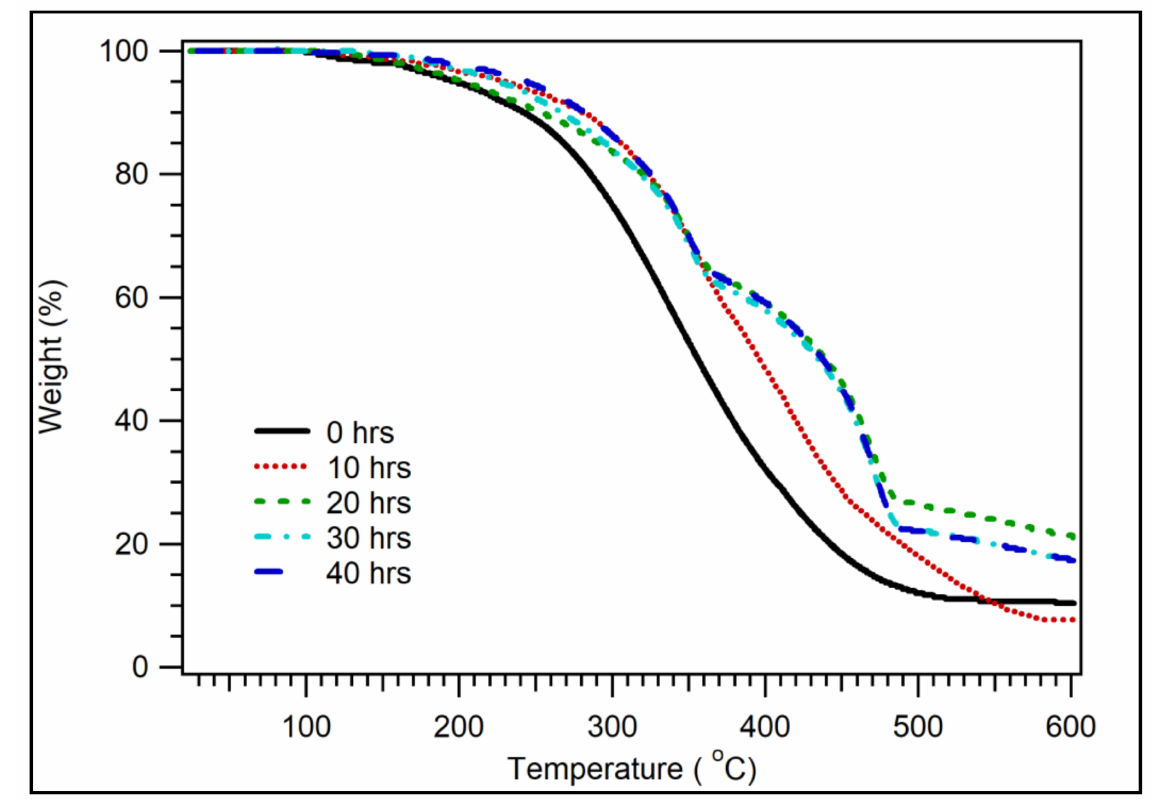
Figure 8. TGA of coconut shell nano-biocomposite for various milling times with 30 wt.% of PP composition. Table 6. Decomposition temperature of coconut shell biocomposite for various milling times.